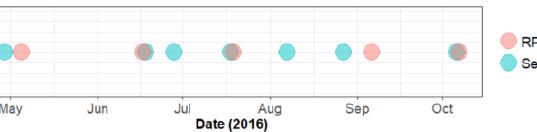
Figure 3. Timeline of data